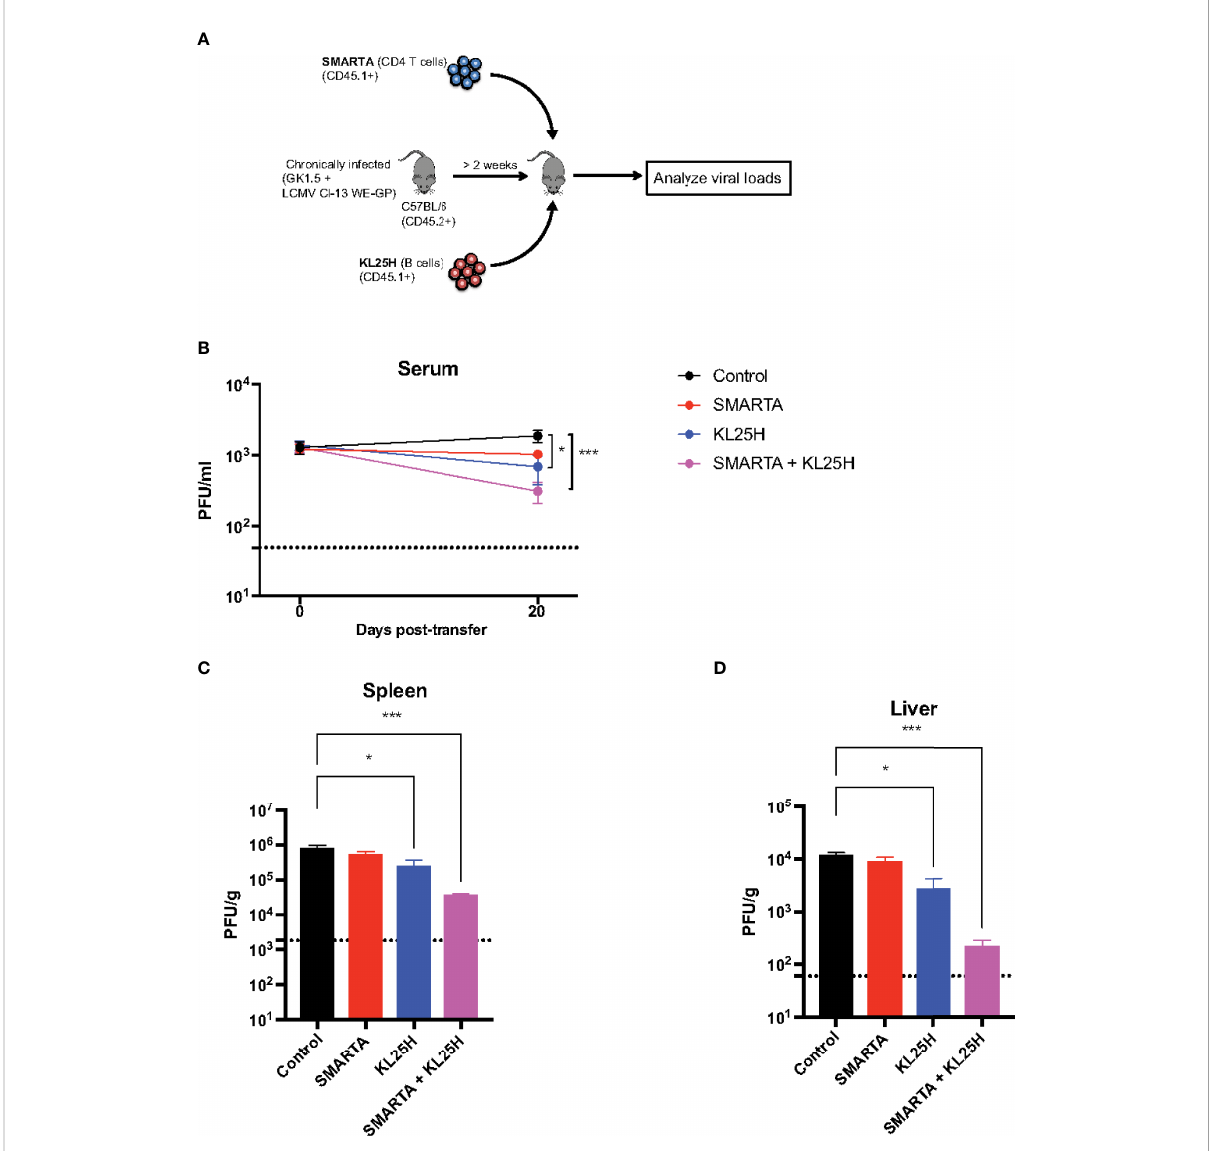
FIGURE 6 Virus-speci fi c CD4 T cells enhance adoptive B cell therapy. (A) Experimental outline for evaluating whether LCMV-speci fi c CD4 T cells augment the ef fi cacy of adoptive B cell therapy. (B) Summary of viral loads in serum. (C) Summary of viral loads in spleen. (D) Summary of viral loads in liver. Experiments were performed 2 times, n=3-5 mice per experiment. Error bars represent SEM. The P values were calculated using the Kruskal-Wallis non-parametric ANOVA test. ns, not signi fi cant. * P <0.05, *** P <0.0005. Dotted line represents limit of